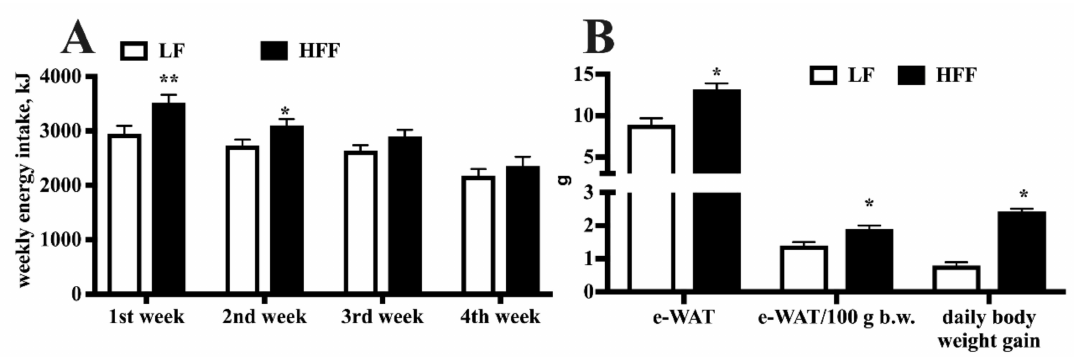
Figure 1. Weekly energy intake ( A ), epididymal white adipose tissue (e-WAT) weight and body weight gain ( B ) in middle-aged rats fed low fat (LF) or high fat-high fructose (HFF) diet for four weeks. Values are the means ± SEM of eight rats. * p < 0.05, ** p < 0.01 compared to low-fat diet (two-way ANOVA followed by Tukey post-test for energy intake data and two-tailed Student’s t-test for e-WAT weight and daily body weight gain